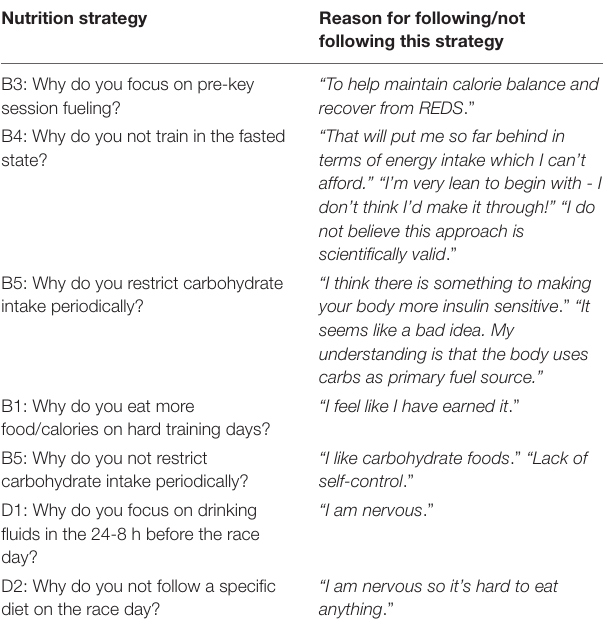
TABLE 2 | Selection of noteworthy athlete quotes regarding why they do, or do not, follow a specific nutrition strategy. Nutrition